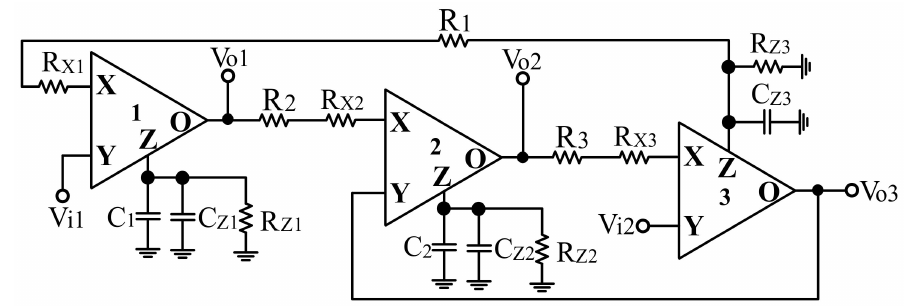
Figure 6. Proposed voltage-mode biquadratic filter including the parasitic elements of